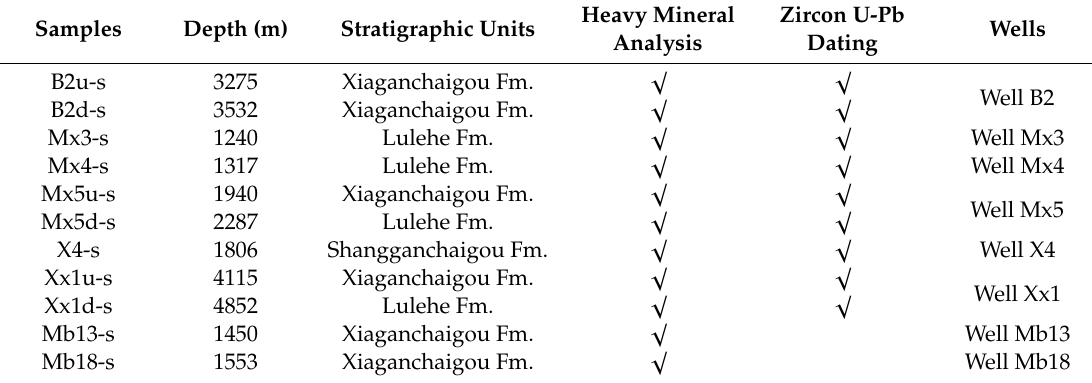
Table 1. Basic information of samples collected for heavy mineral analysis and detrital zircon U-Pb